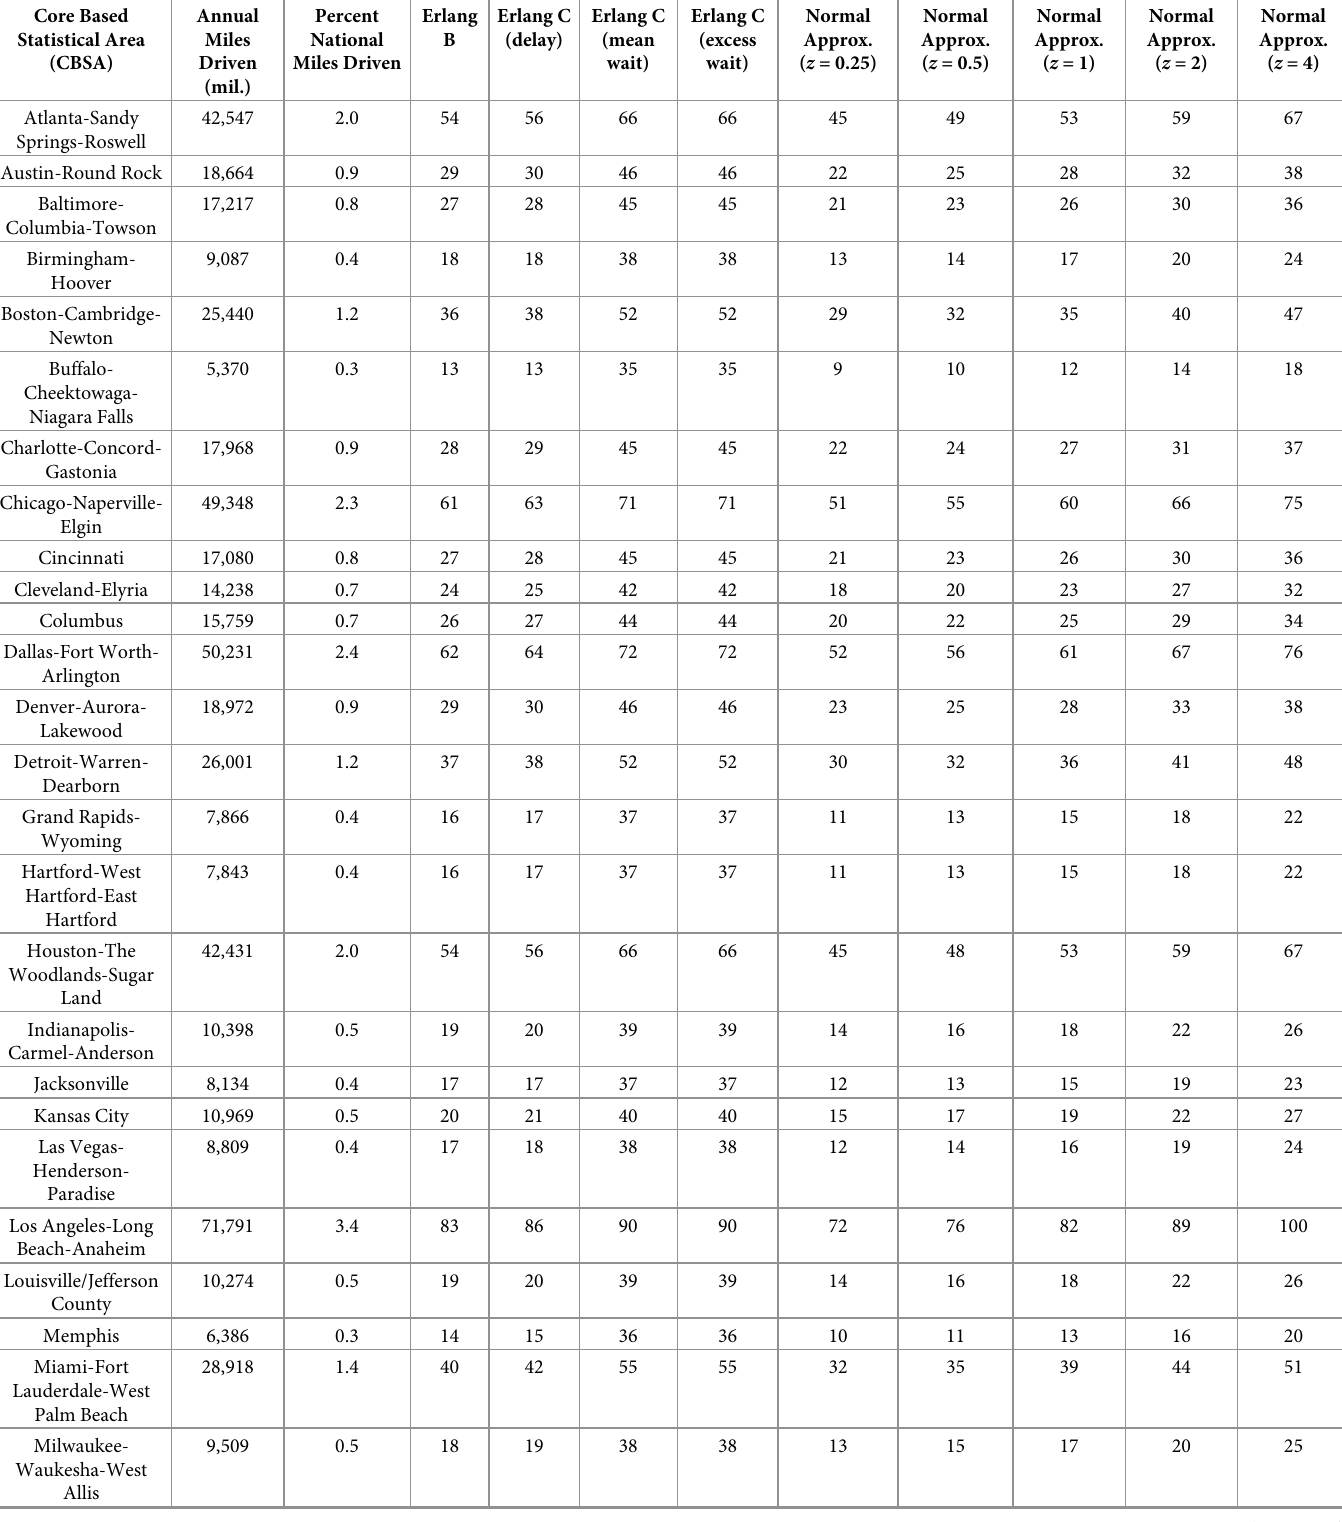
Table 2. Estimated number of remote drivers needed in select cities nationwide during peak travel time, under five staffing models. Core Based Statistical Area